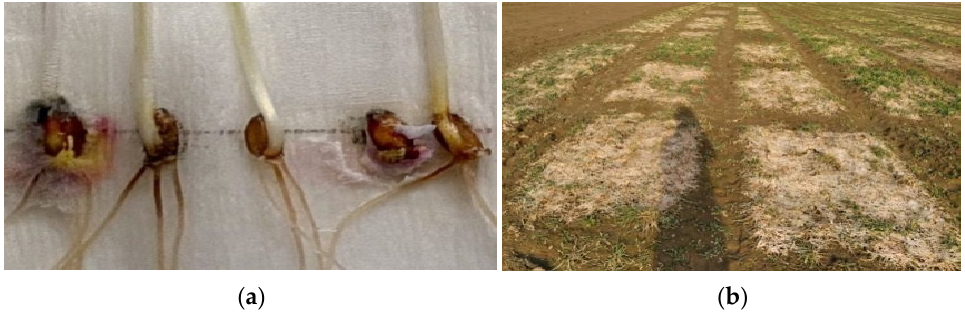
Figure 2. ( a )—Grains infected by Microdochium nivale ; ( b )—an experimental field infected by Microdochium nivale , 2021.